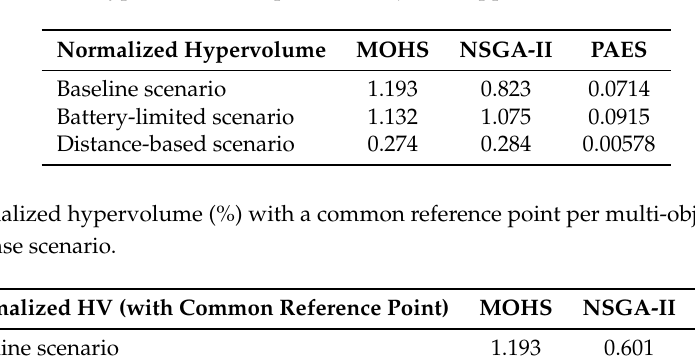
Table 2. Normalized hypervolume (%) per multi-objective approach and real use case scenario.